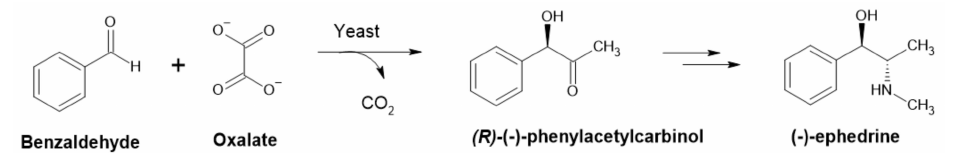
Figure 7. Synthesis of (R) -PAC and structure of ( − )-ephedrine.